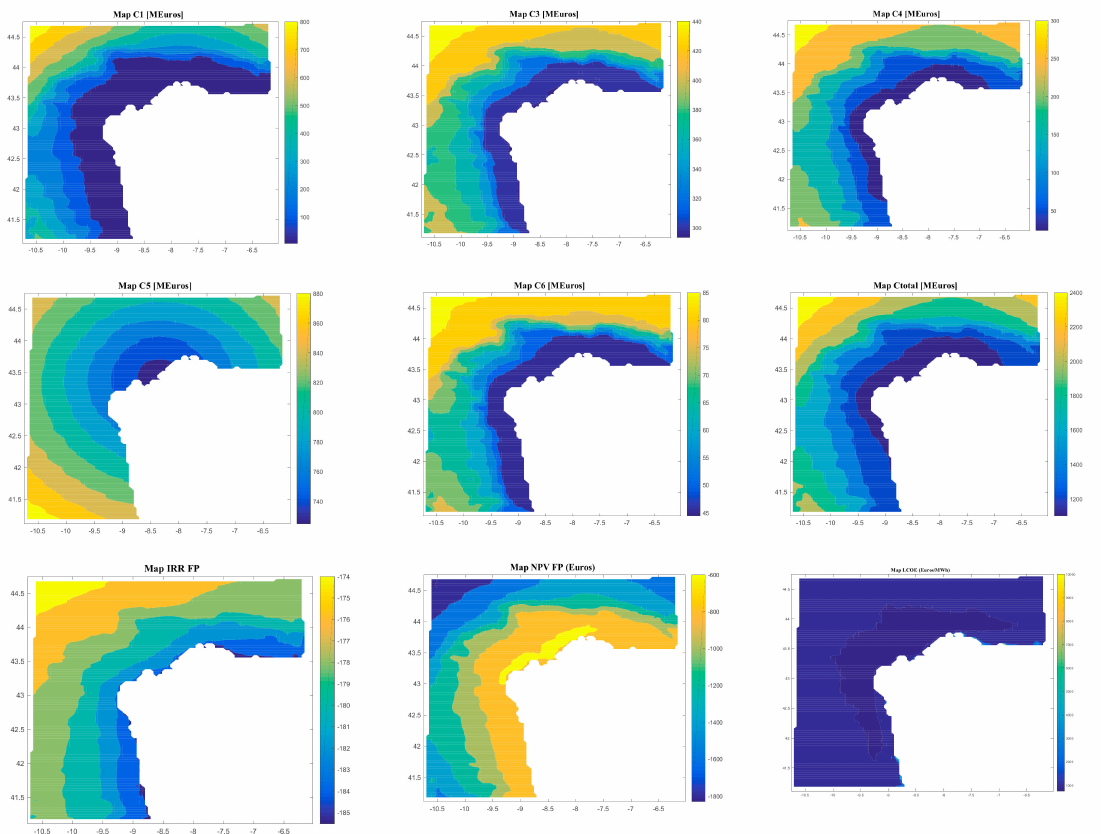
Figure 10. Results (C1, C1, C3, C4, C5, C6, Ctotal, LCOE, DPBP, IRR, NPV) for Case